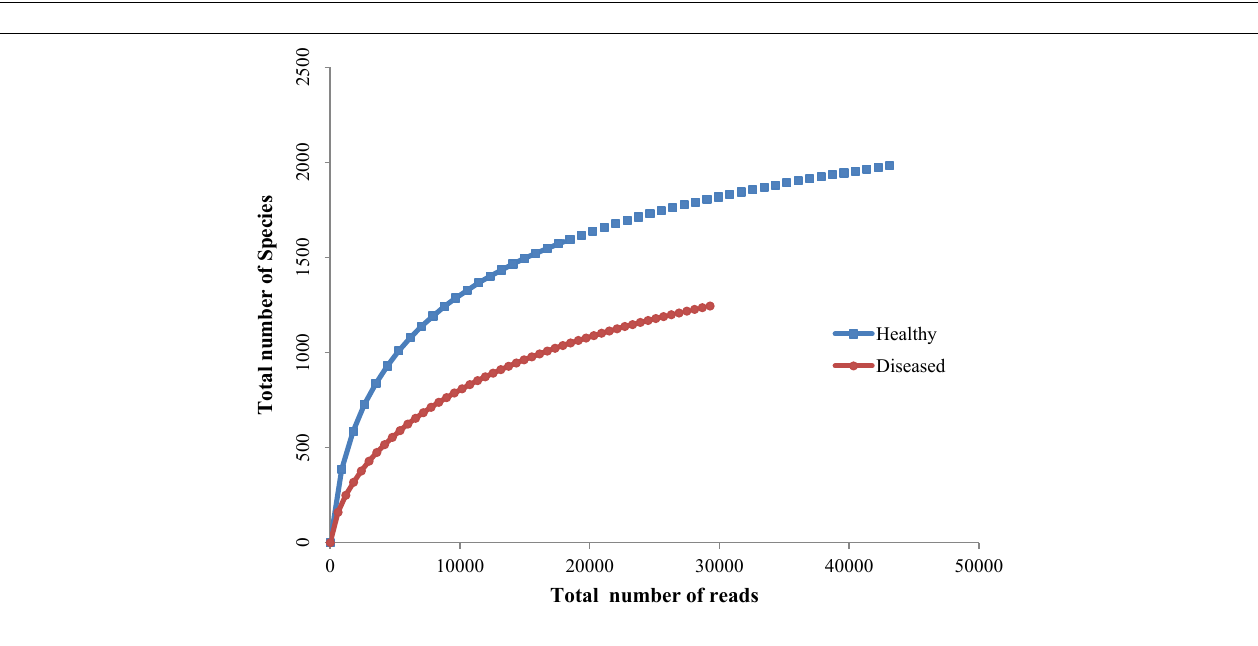
FIGURE 4 | Rarefaction curve of healthy and SGA affected A.